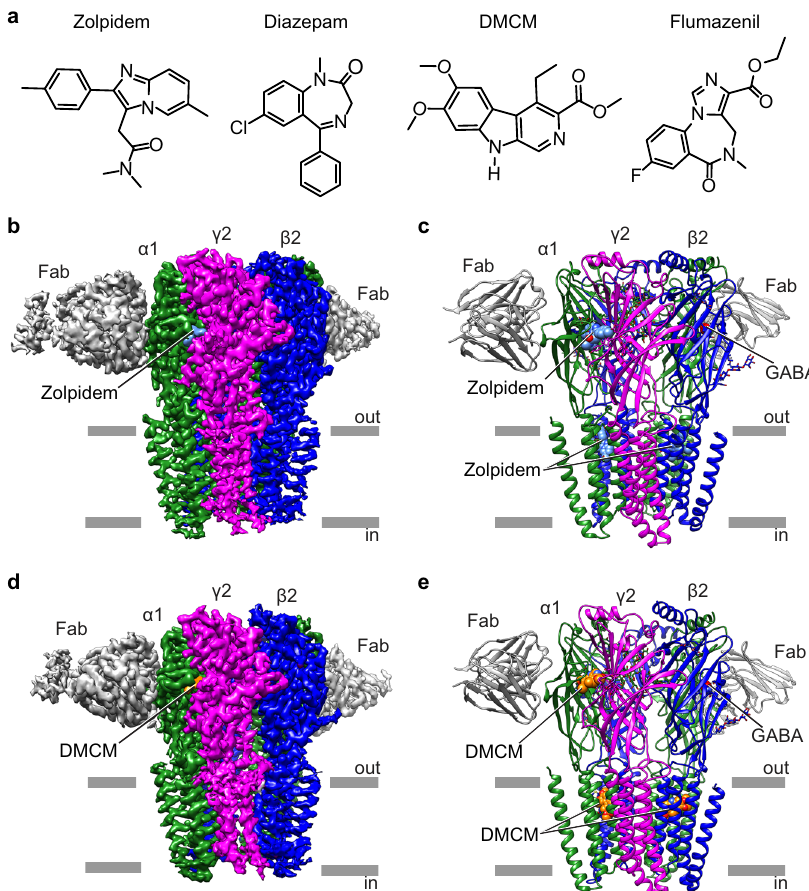
Fig.1|Representativebenzodiazepine-siteligandsandoverallstructuresofthe GABA A receptor-ligand complexes. a Zolpidem is an imidazopyridine; diazepam and fl umazenil haveabenzodiazepine core;DMCM isa β -carboline. b , c Sideviews of the 3D reconstruction and atomic model of GABA A receptor-zolpidem complex